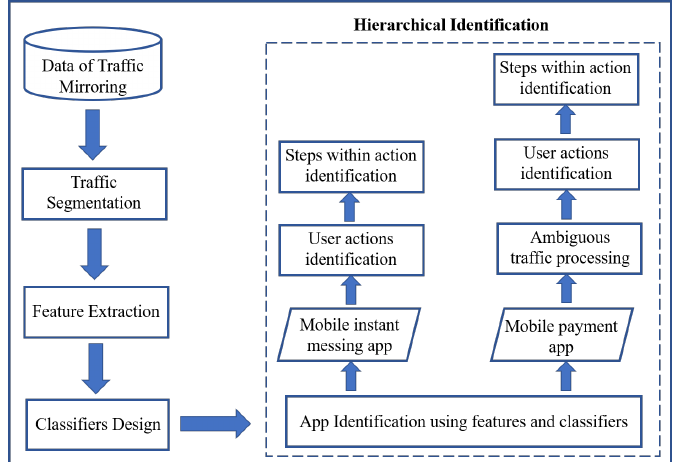
Figure 2. Hierarchical identification